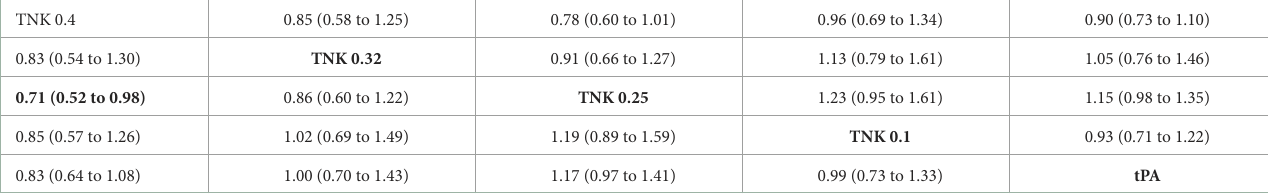
mRS,Modifiedranklescale;TNK,tenecteplase;tPA,alteplase.Comparisonsshouldbereadfromlefttoright.RRabove1favorstherow-definingcategory(higherratesoffunctionalindependence); Significantresultsareinboldfont.